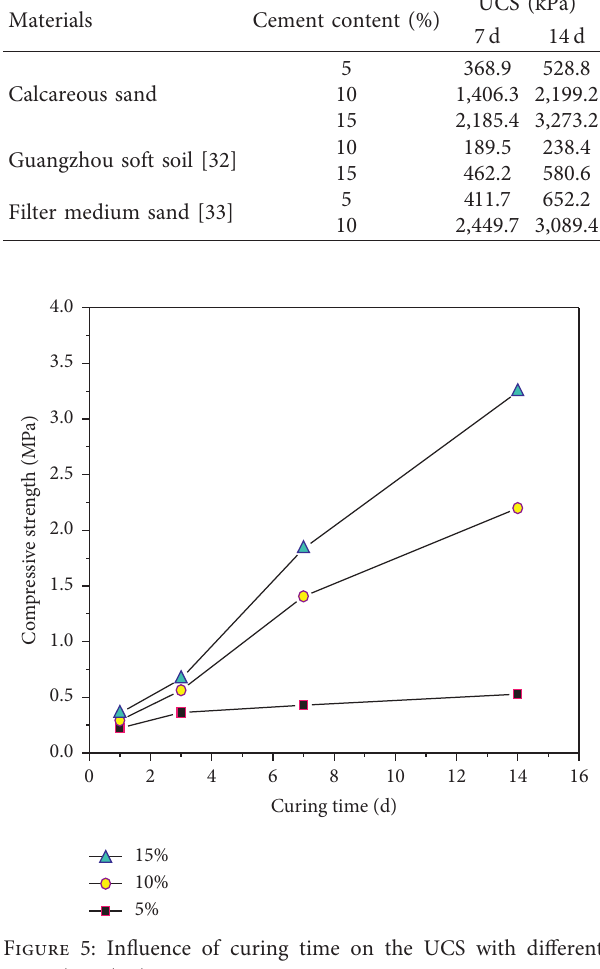
Table 5: The peak strength of UCS tests. Materials